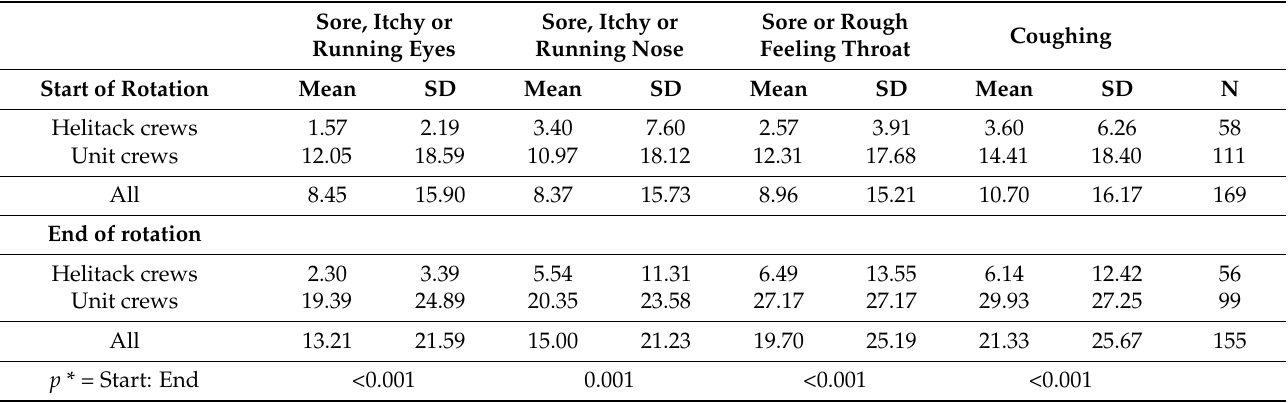
Table 2. Mean symptom scores at the start and end of rotation and crew type. How much have you been bothered by the symptom in the last 24 h (on a visual analogue scale 0–100)? Sore, Itchy or Sore, Itchy or Sore or Rough Running Eyes Running Nose Feeling Throat